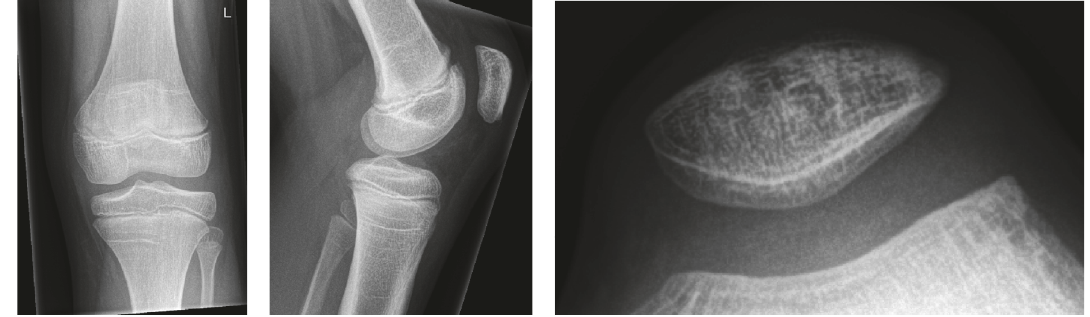
Figure 4: Follow-up radiographs 17 months after surgery revealing an almost normally appearing